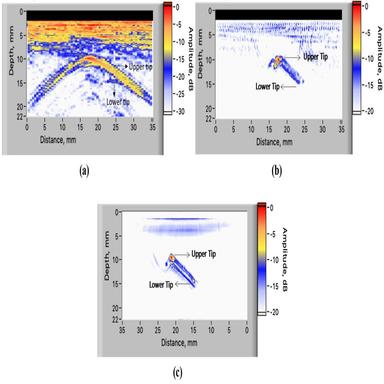
B-scan images for 51 inclined slot (a) Raw PA-SAFT (b) Processed PA-SAFT and (c) FMC + TFM.